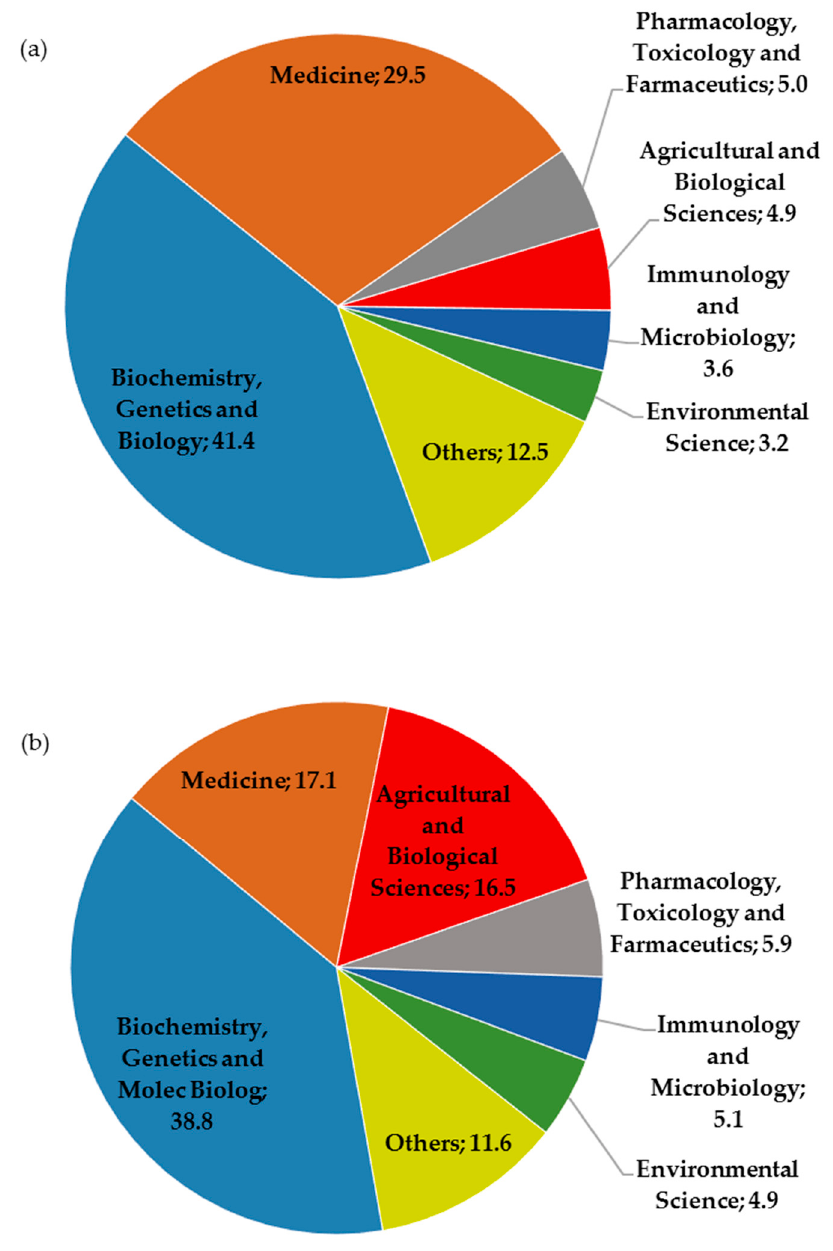
Figure 2. Distribution (%) of worldwide research on: ( a ) DDR and ( b ) DDR & Plant by subject area, as classified by Scopus.